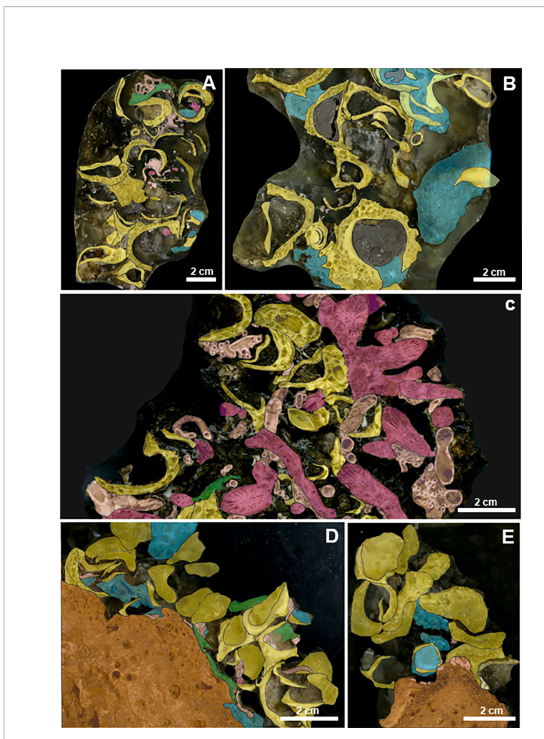
FIGURE 3 HD digitized images of impregnated sample slices of the bioconstructions. Scale bar = 2 cm. Legend: yellow = bivalves; violet = scleractinians; blue = sponges; green = bryozoans; pink = serpulids; and orange = biogenic substrate. (A) TRM. The bioconstruction is made up of valves of N. cochlear . (B) The biogenic framework at TRM is deeply bioeroded by sponges. (C) MON. Scleractinians and mollusks within the framework of the bioconstruction. (D) CAP. N. cochlear bioconstruction develops on an older biogenic substrate. (E) CAP. Details of the framework.